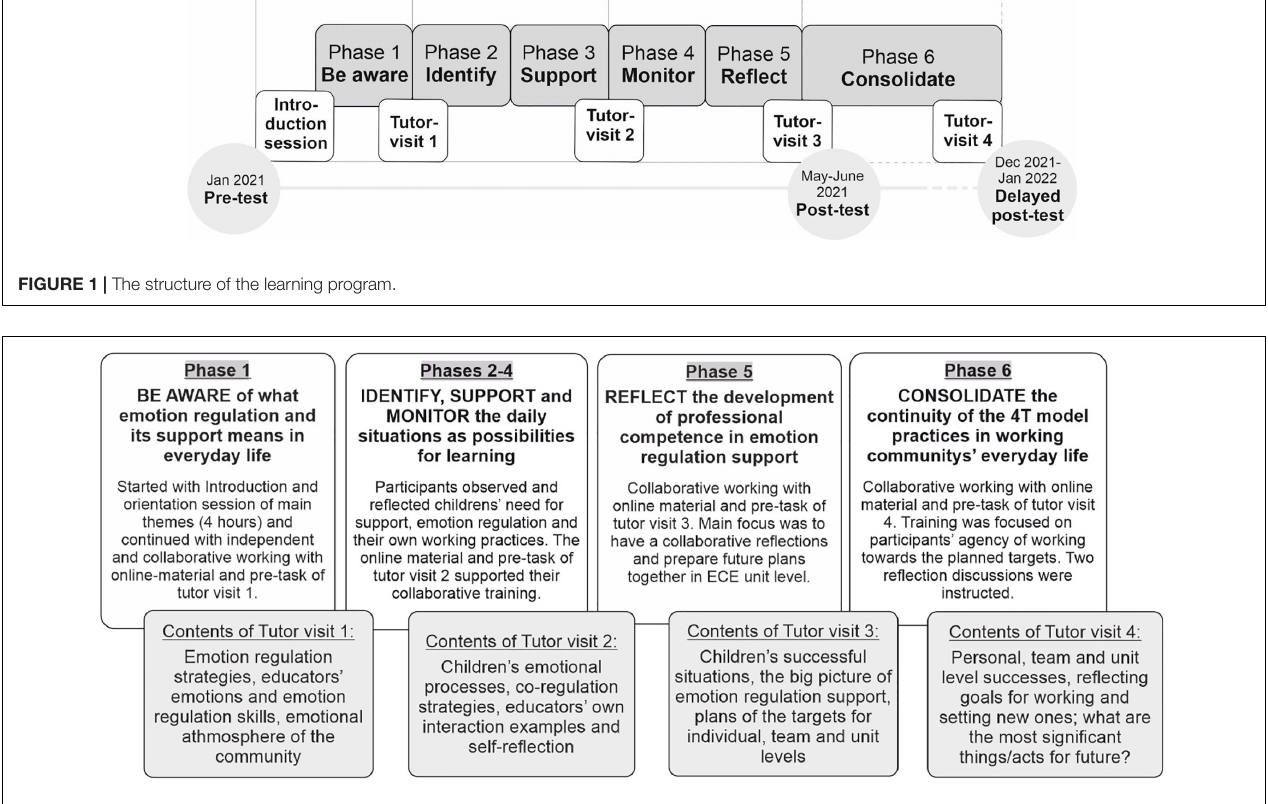
FIGURE 2 | The outline of the topics in Phases 1–6 and the Tutor